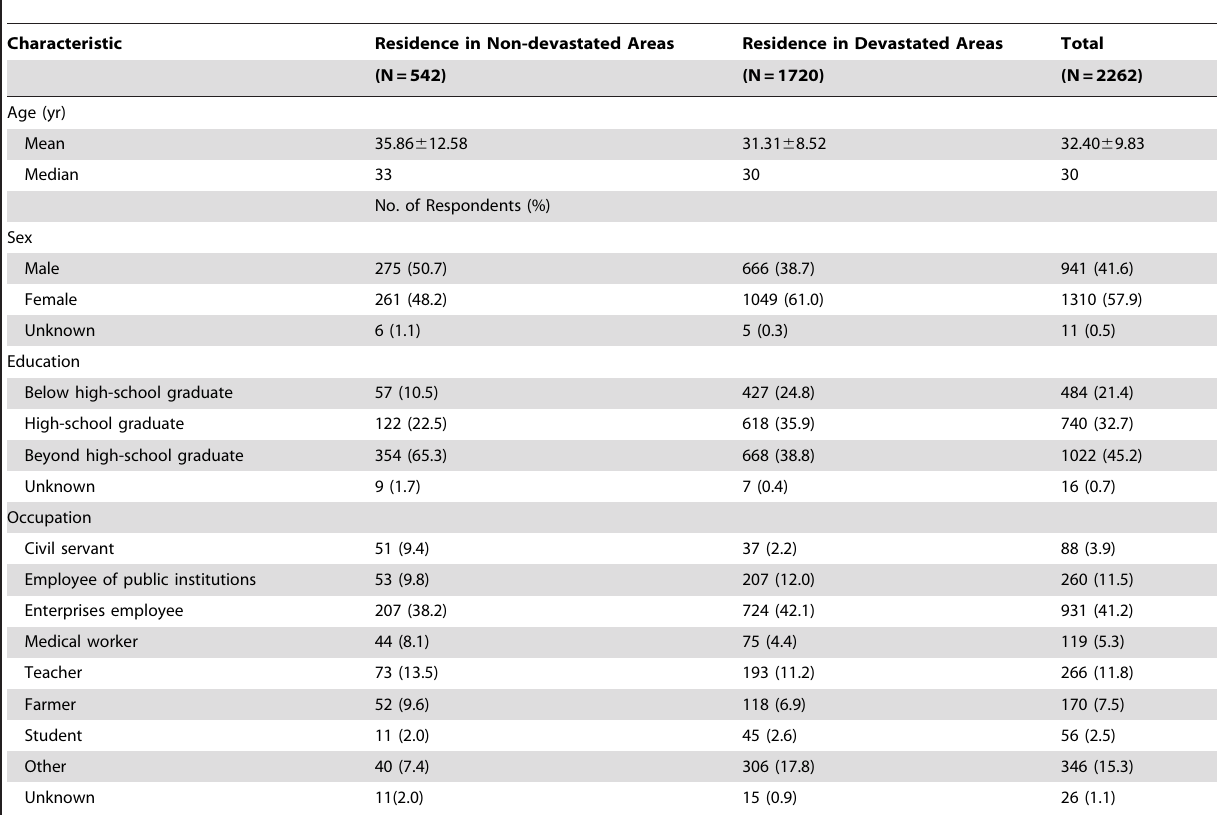
Table 1. Demographic Characteristics of Residents in Non-devastated Areas and Devastated Areas.